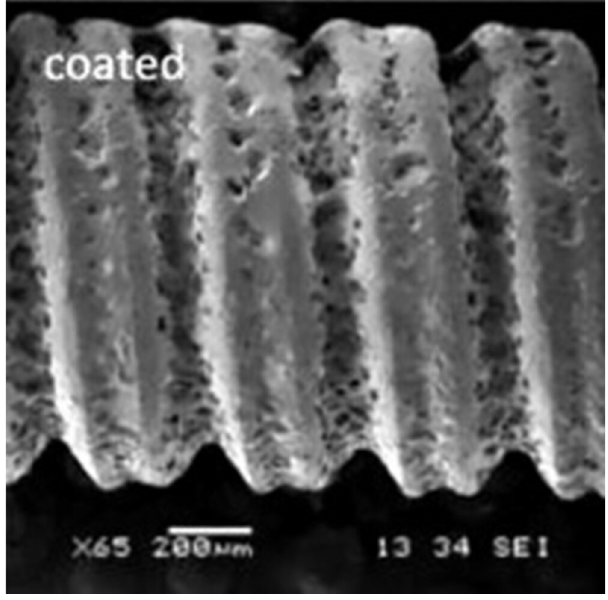
Figure 16. BG coating on a Ti 6 Al 4 V implant screw [254].